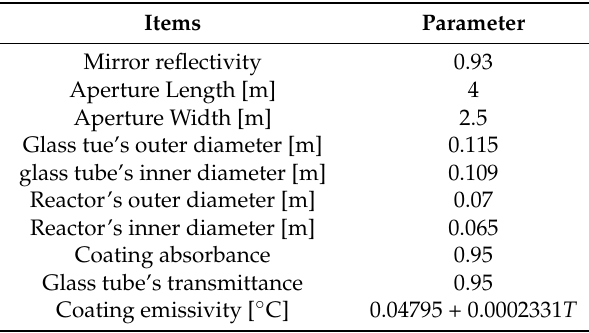
Table 1. Typical dimensions of the